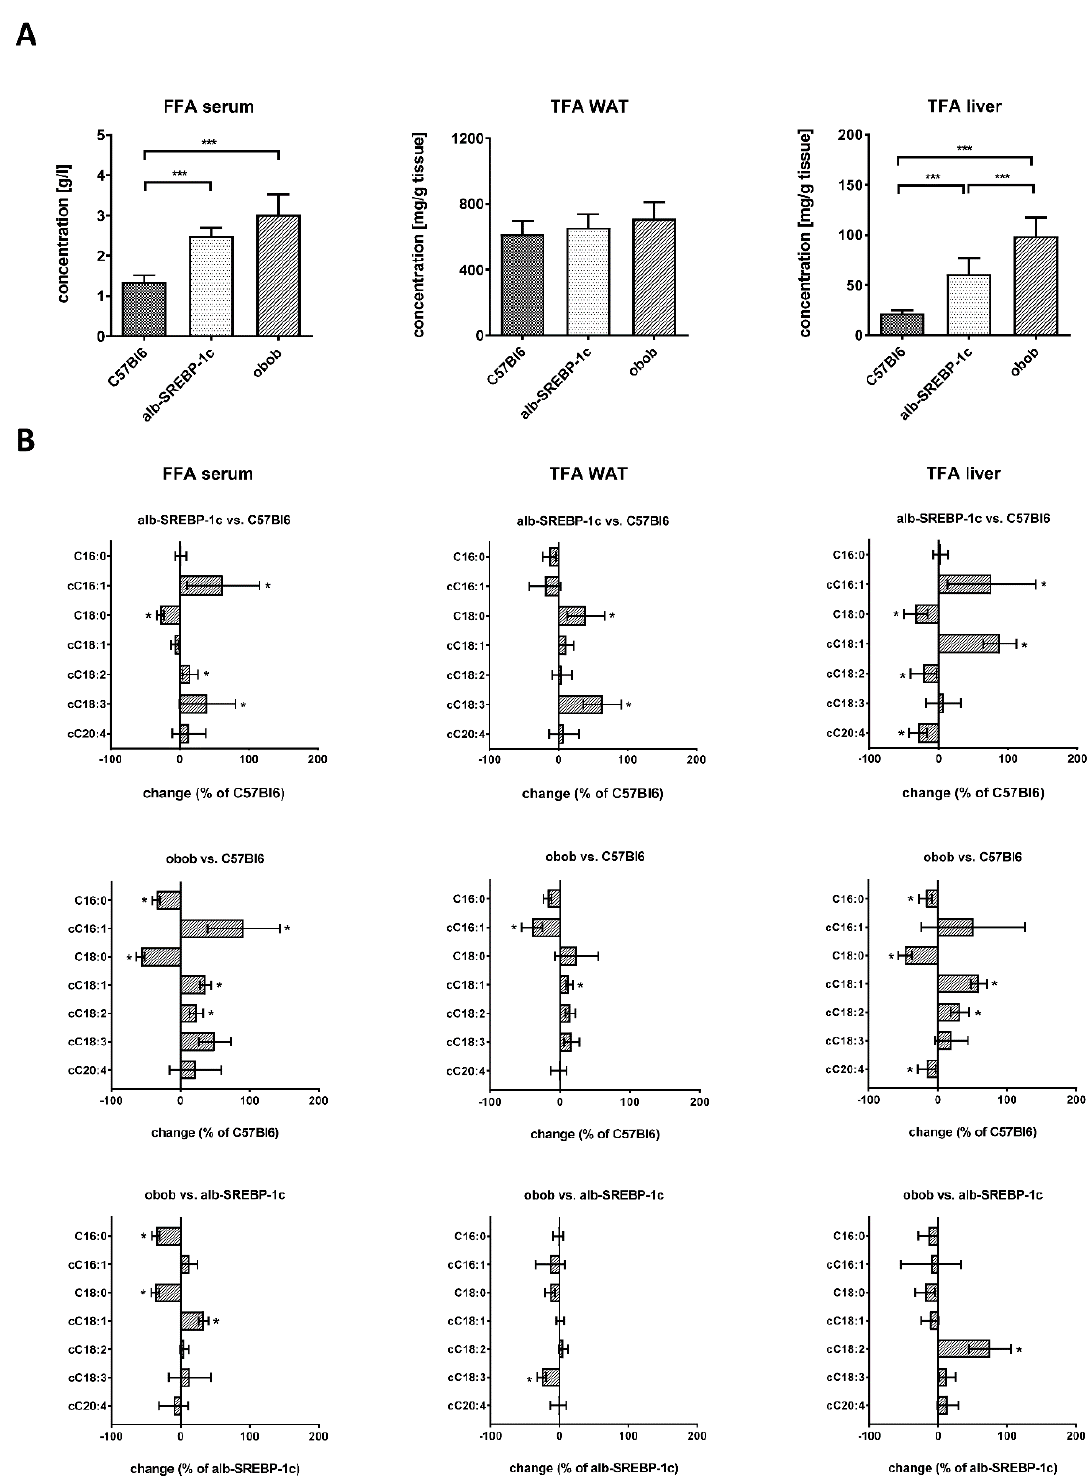
Figure 1. Lipid compositions of the C57Bl6, alb-SREBP-1c, and obob mice. ( A ) Total and specific fractional composition of the serum free fatty acids (FFAs) and the liver or adipose tissue total fatty acids (TFAs); ( B ) the percentage changes in the serum FFA and the liver or adipose tissue TFAs in alb-SREBP-1c vs. C57Bl6, obob vs. C57Bl6, and obob vs. alb-SREBP-1c. Data are expressed as mean ± SD ( n = 8 of each phenotype). * p < 0.05, ** p < 0.01, and *** p < 0.001, by one-way ANOVA, with a Sidak post-hoc test (A) or students’ t-test (B).